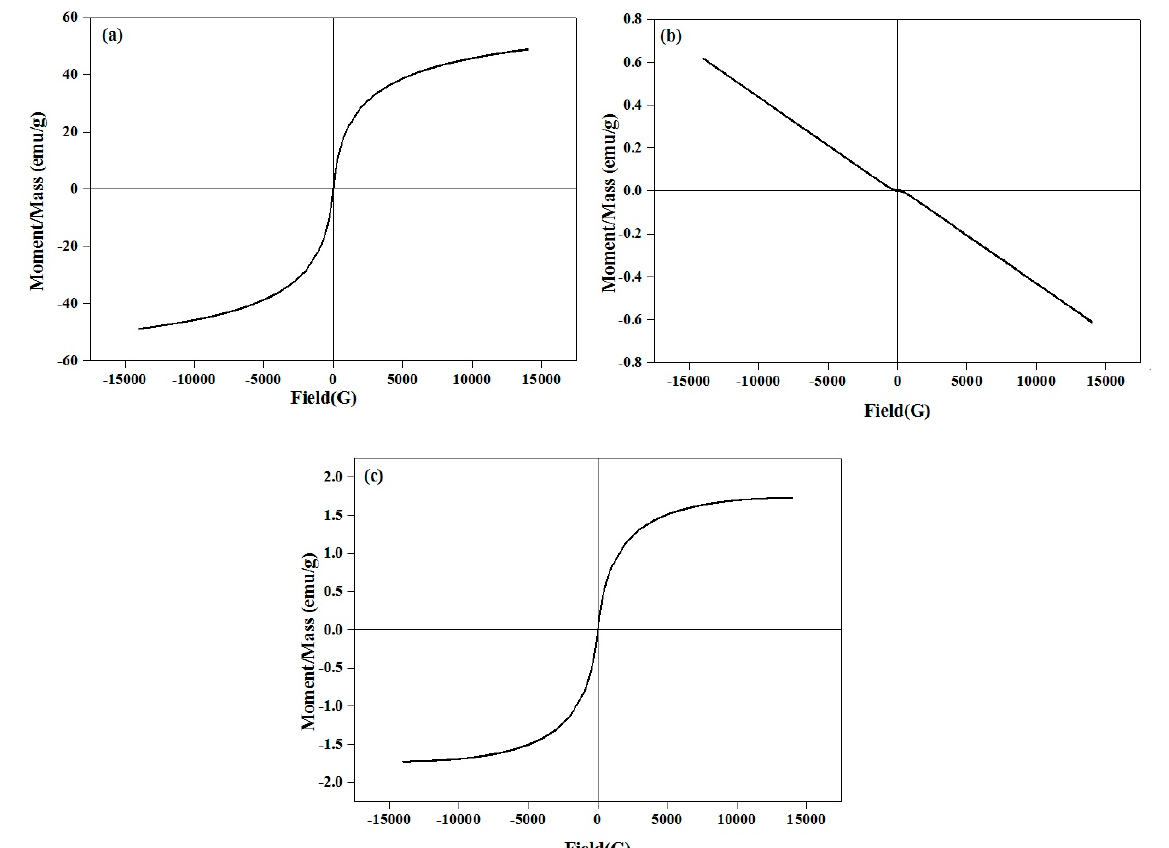
Figure 3. Hysteresis loop of the ( a ) maghemite ( γ -Fe 2 O 3 ), ( b ) β W, and ( c ) β WMAF powders.